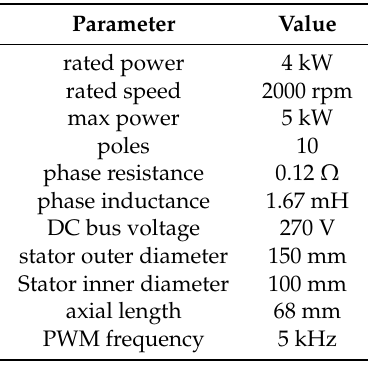
Table 4. Model parameters of SPMSM.